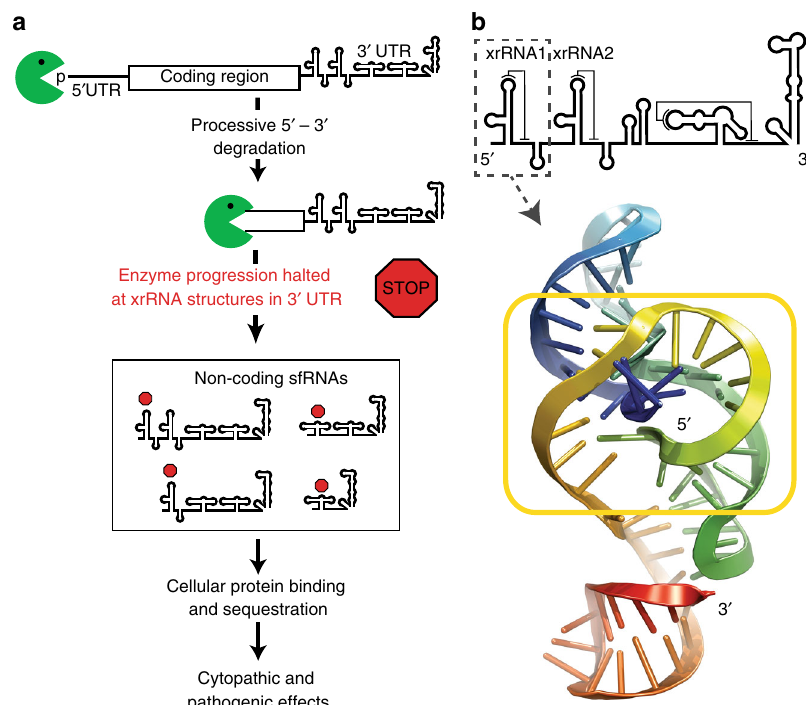
Fig. 1 Formation of sfRNAs by Xrn1 resistance. a Xrn1 degrades the viral genomic RNA in a 5 ′ – 3 ′ direction, but halts at xrRNA structures. The resultant noncoding viral sfRNA is formed, which affects several pathways. b Three-dimensional structure of the upstream xrRNA from Zika virus shown in cartoon form, in rainbow. The 5 ′ -end is blue and 3 ′ -end is red. The fold forms a unique ring-like structure (yellow box) through which the 5 ′ -end of the RNA passes. The location of this xrRNA in a generic MBFV 3 ′ -UTR is shown above the